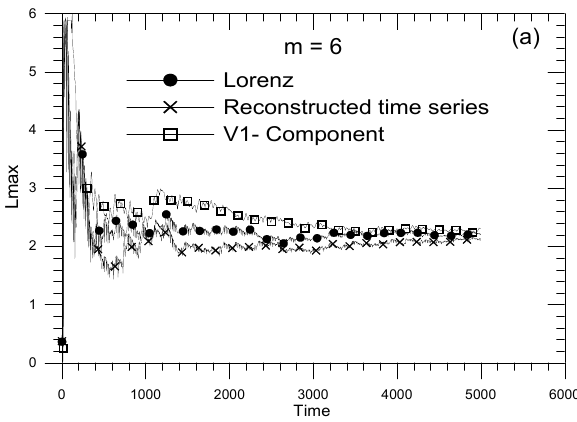
Figure 4 Fig. 4. The largest Lyapunov exponent L max as a function of the evolution time, for the variable x(t) of the Lorenz dynamical sys- tem, its reconstructed and its V 1 -component time series estimated for embedding dimension m = 6 and the best delay